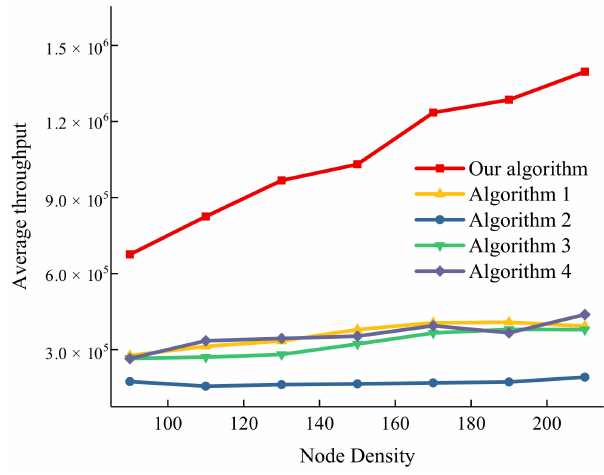
Figure 5. Network throughput under a different number of nodes.